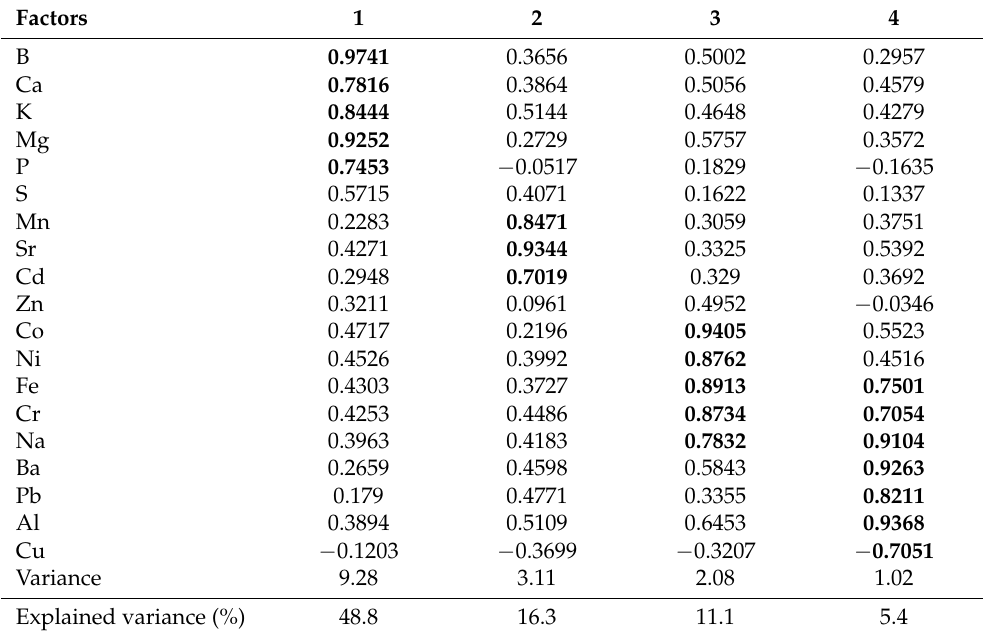
Table 11. Factor loadings from principal axis factor analysis (Varimax rotation) for nineteen chemical elements of white wine in twenty-one bentonite product treatments (Debrecen-Pallag, Hungary). Factor loadings above 0.69 were significant at p = 0.05. Bold figures represent the significant ( p < 0.05) factor